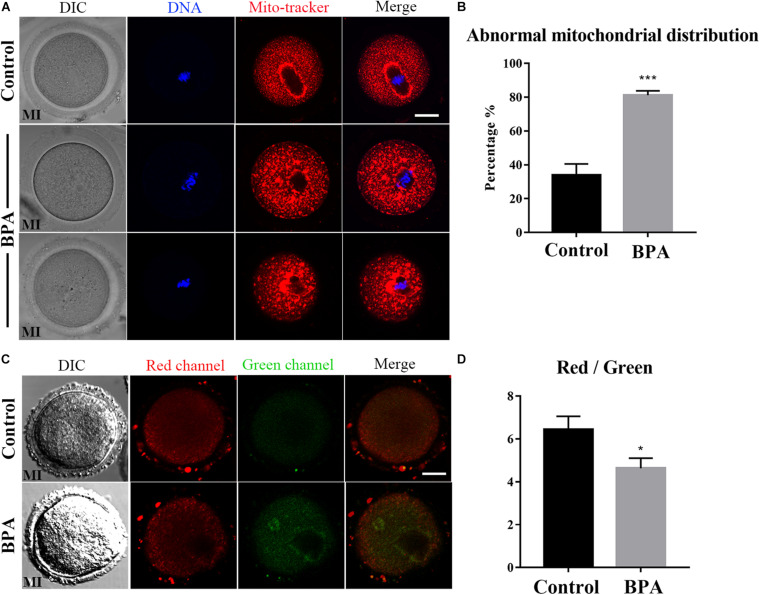
Effects of BPA on mitochondrial distribution and functions during mouse oocyte maturation. (A) Representative images of mitochondrial distribution in the oocyte cytoplasm in the control group and BPA treatment group. Red, Mito; Blue, DNA. Bar = 20 μm. (B) Abnormal distribution of mitochondrial significantly increased in the BPA treatment oocytes compared with the control oocytes. ***, significant difference (P < 0.001). (C) The typical picture for JC1 red channel and green channel after BPA treatment. Bar = 20 μm. (D) The JC1 signal (red/green ratio) after BPA treatment compare with the control group, the JC-1 red/green fluorescence ratio was significantly reduced in BPA treatment group. *, significant difference (P < 0.05).